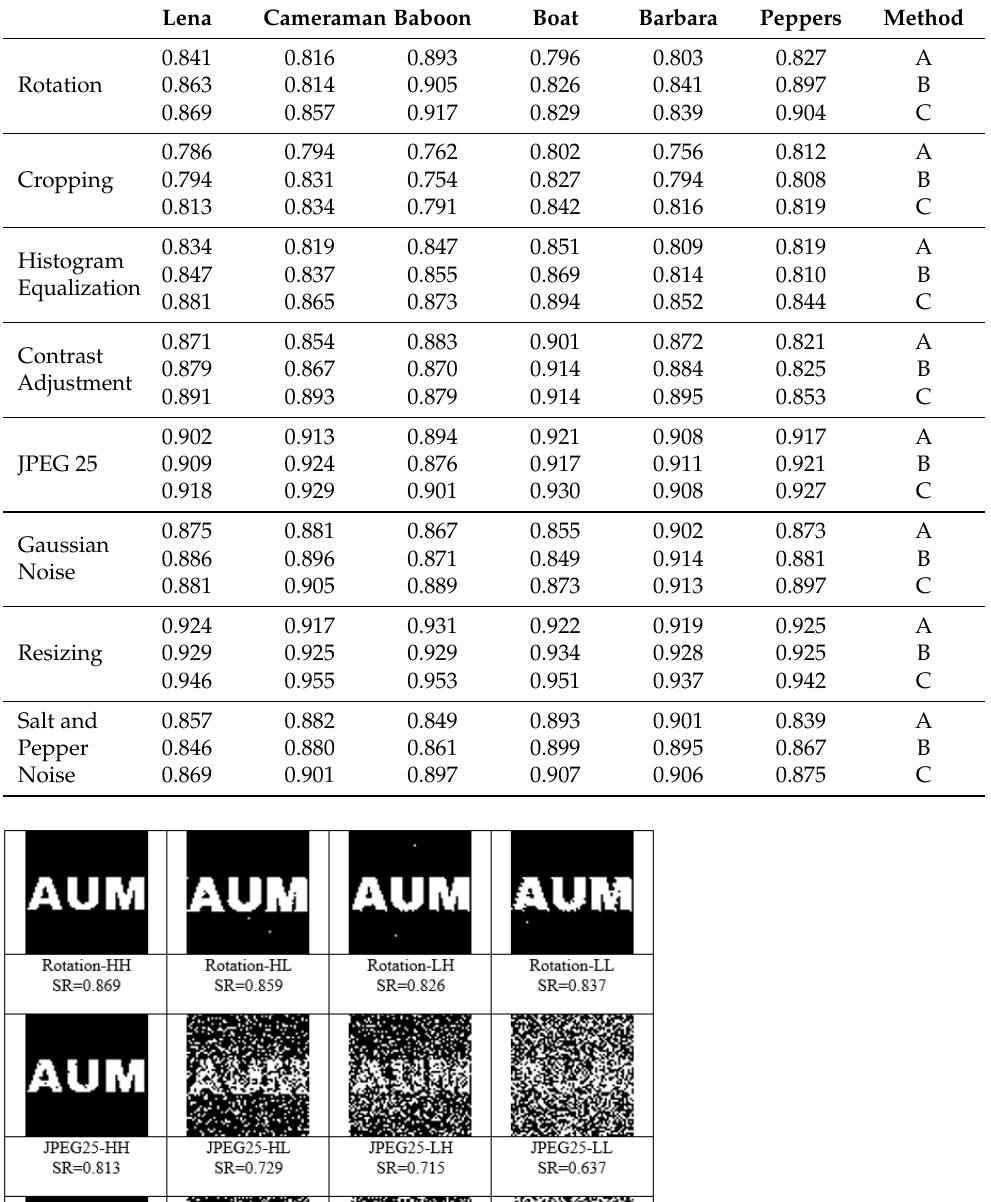
Table 5. Similarity Ratio (SR) values after common attacks (A: DWT B: Block DWT C: FSF Block DWT).